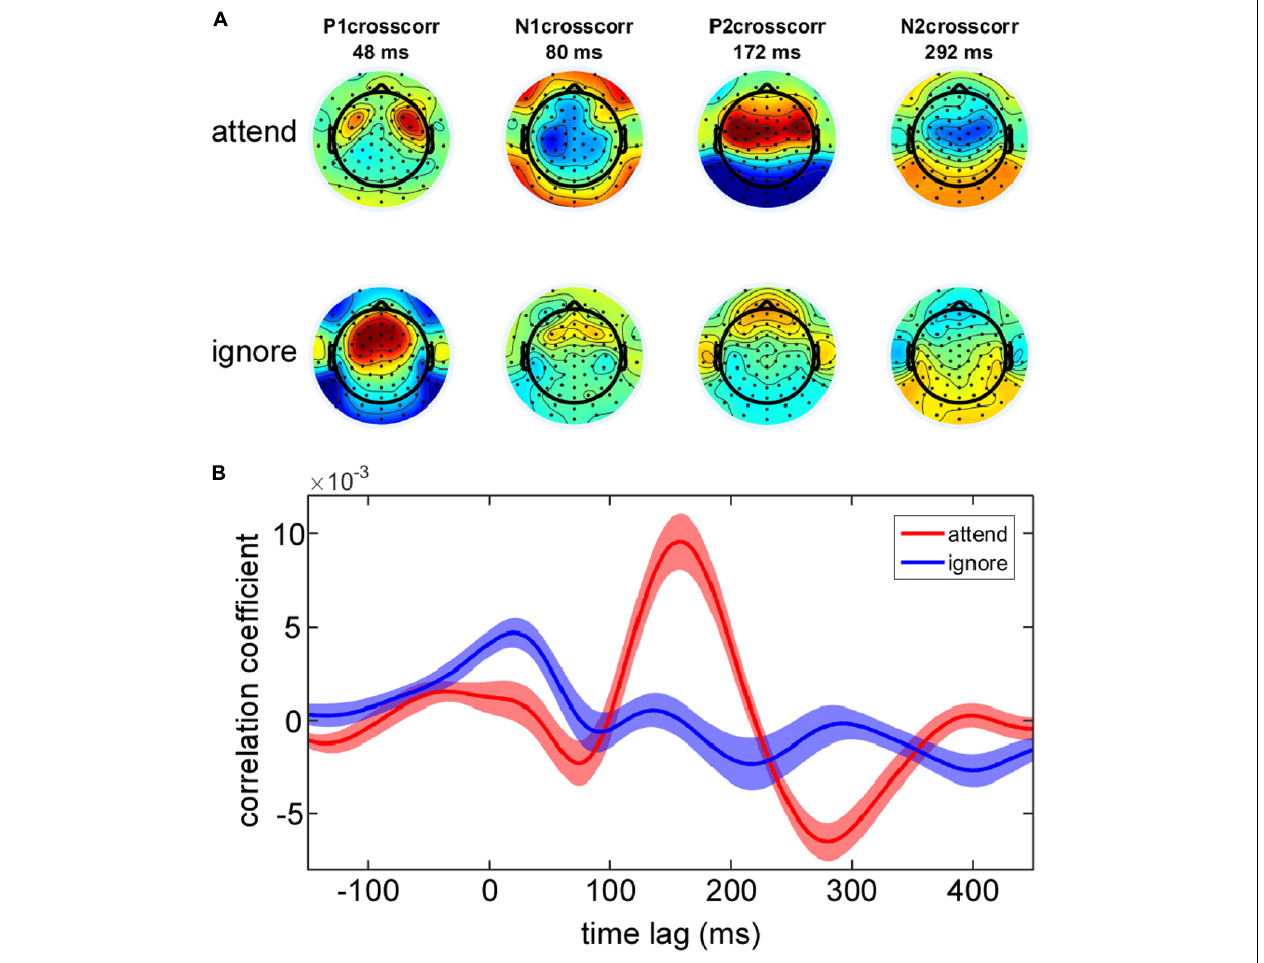
FIGURE 2 | Group average EEG impulse response and corresponding topographies. (A) Topographies of the main positive and negative deflections (P1crosscorr, N1crosscorr, P2crosscorr, and N2crosscorr) of the group average EEG impulse response reflect which electrode sites contribute most to the neural tracking of the attended and ignored speech envelope. (B) EEG impulse response with ± 1 SEM (shaded area) is plotted as a function of time lag separately for the attended and ignored speech envelope at EEG channel